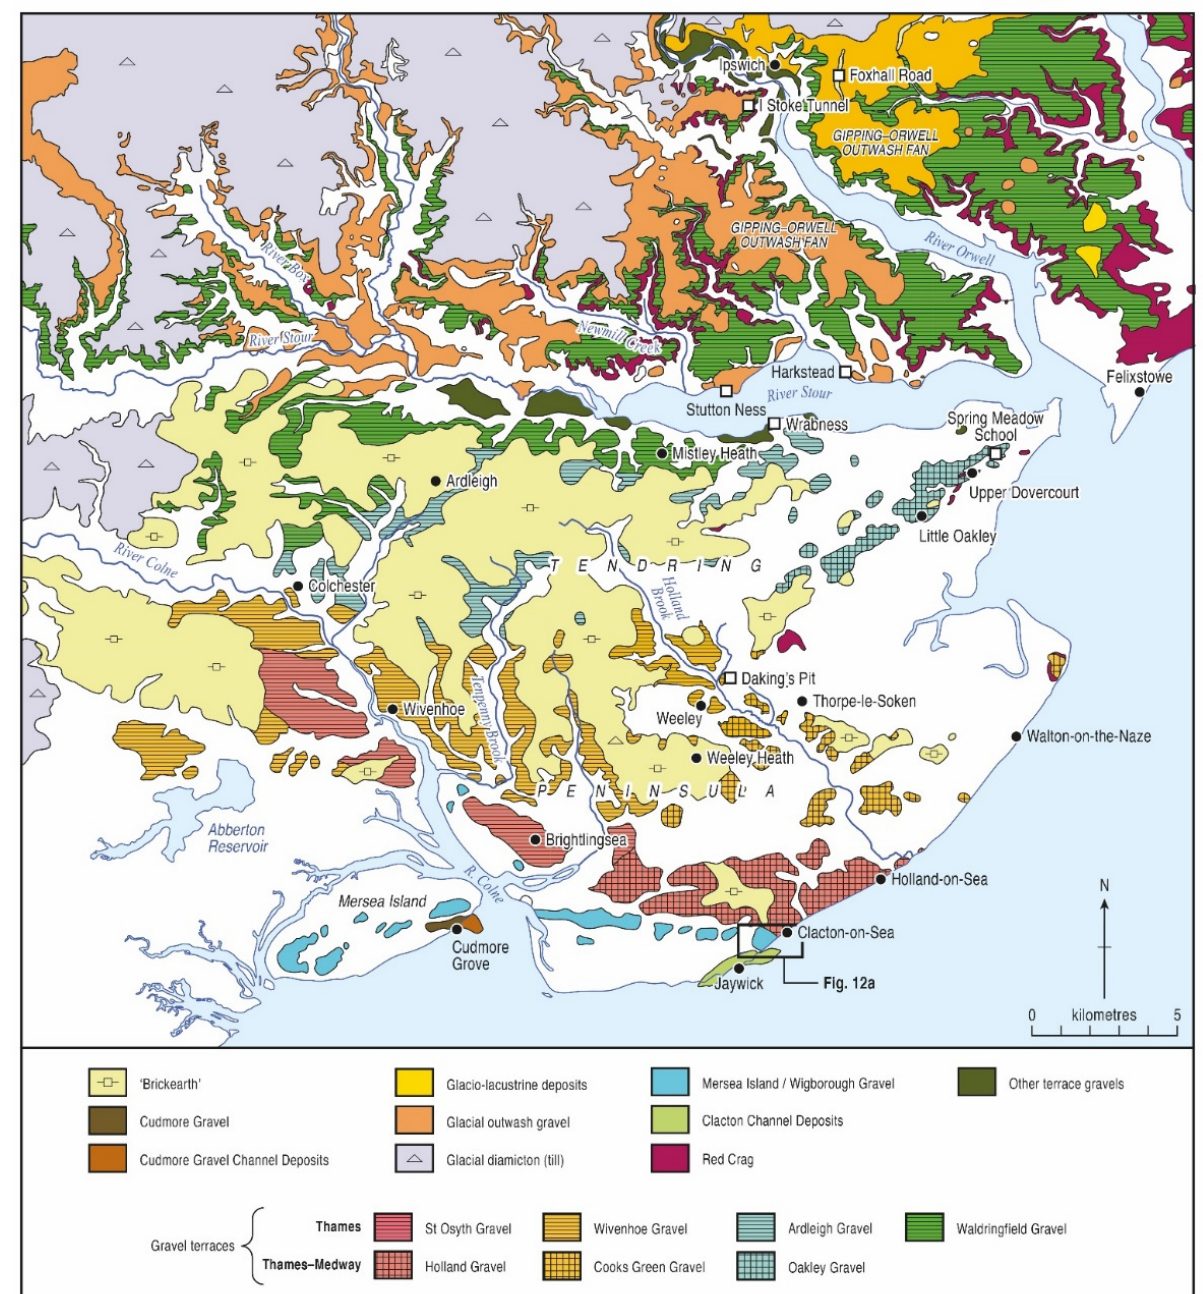
Figure 3. Quaternary deposits of the study area, updated from [31] and showing the sites from which new data have been obtained. The location of this figure is indicated on Figure 1.